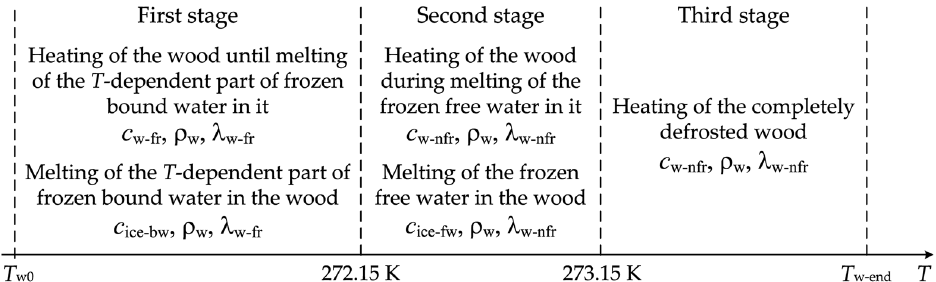
Figure 1. Stages of the wood defrosting process and thermo-physical characteristics of wood used in them.